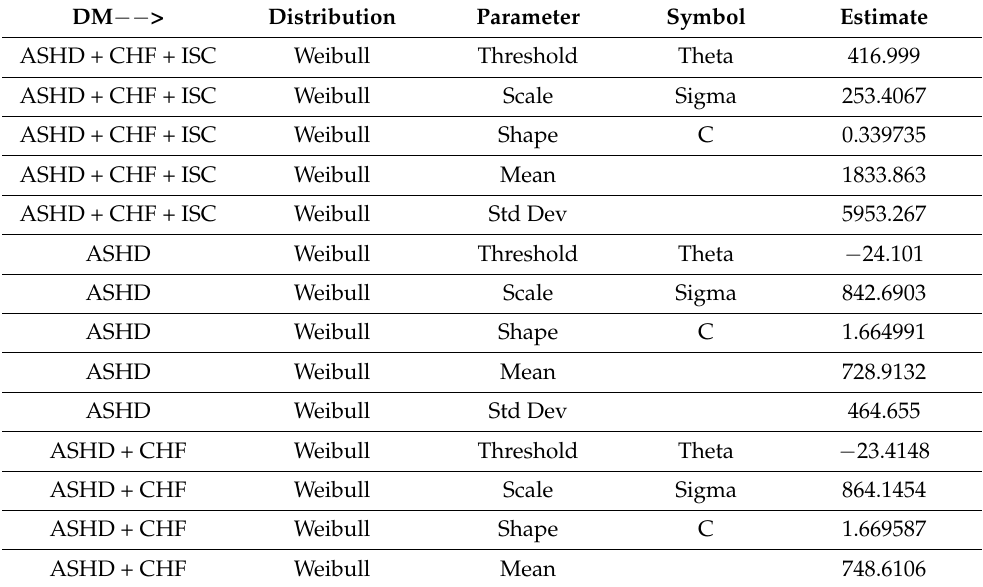
Table A2. Weibull distribution with associated parameters from diabetes mellitus to different